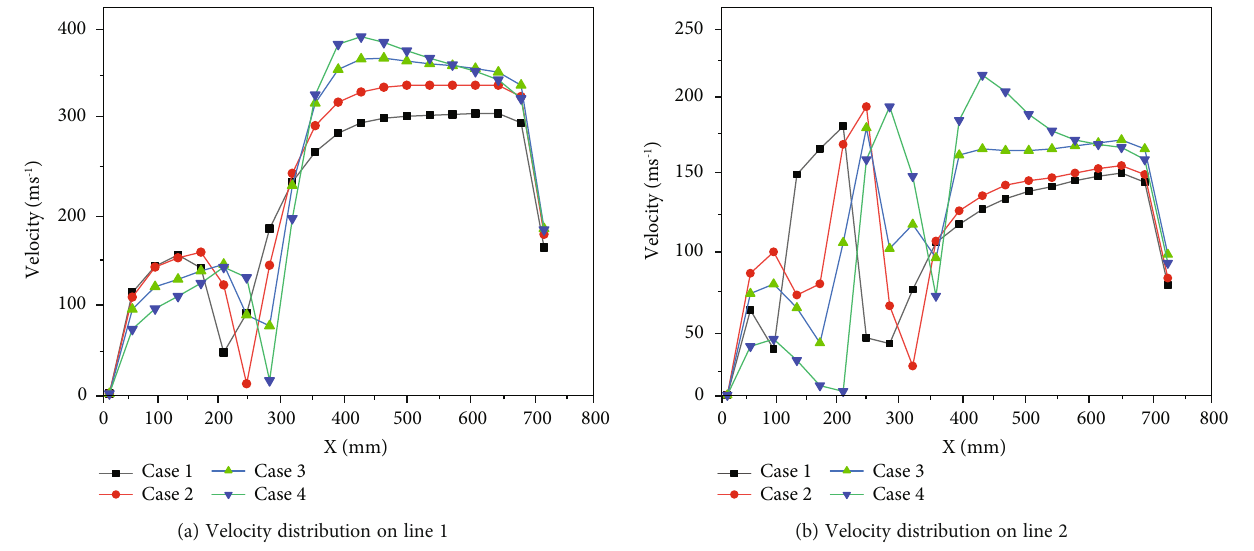
Figure 18: Velocity distribution on two marking